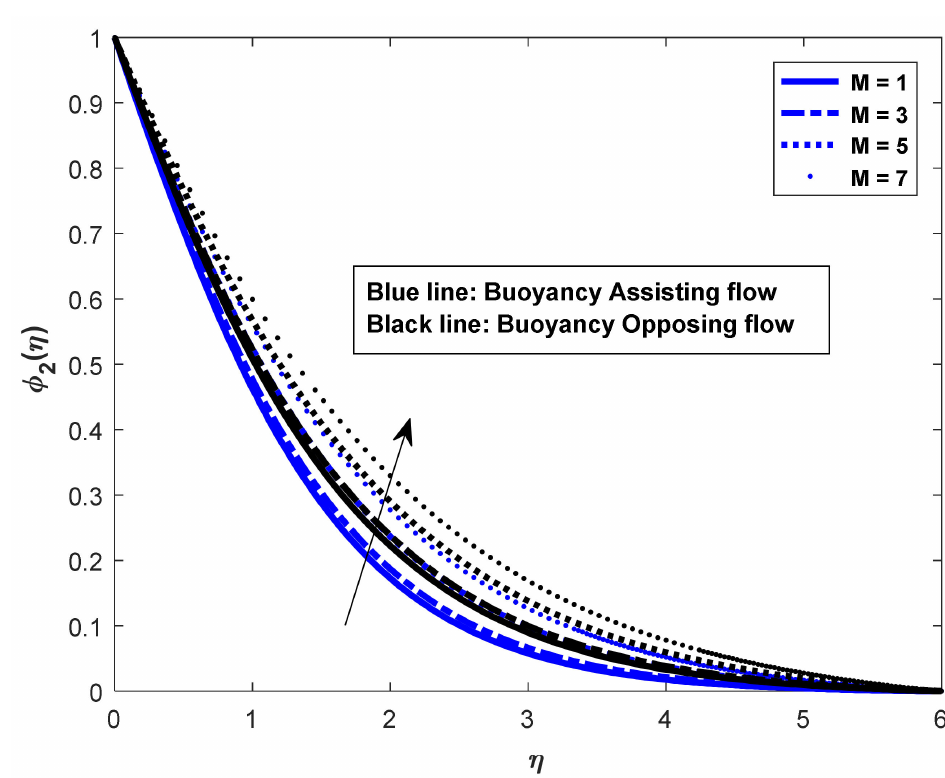
Figure 4. M on salt_2